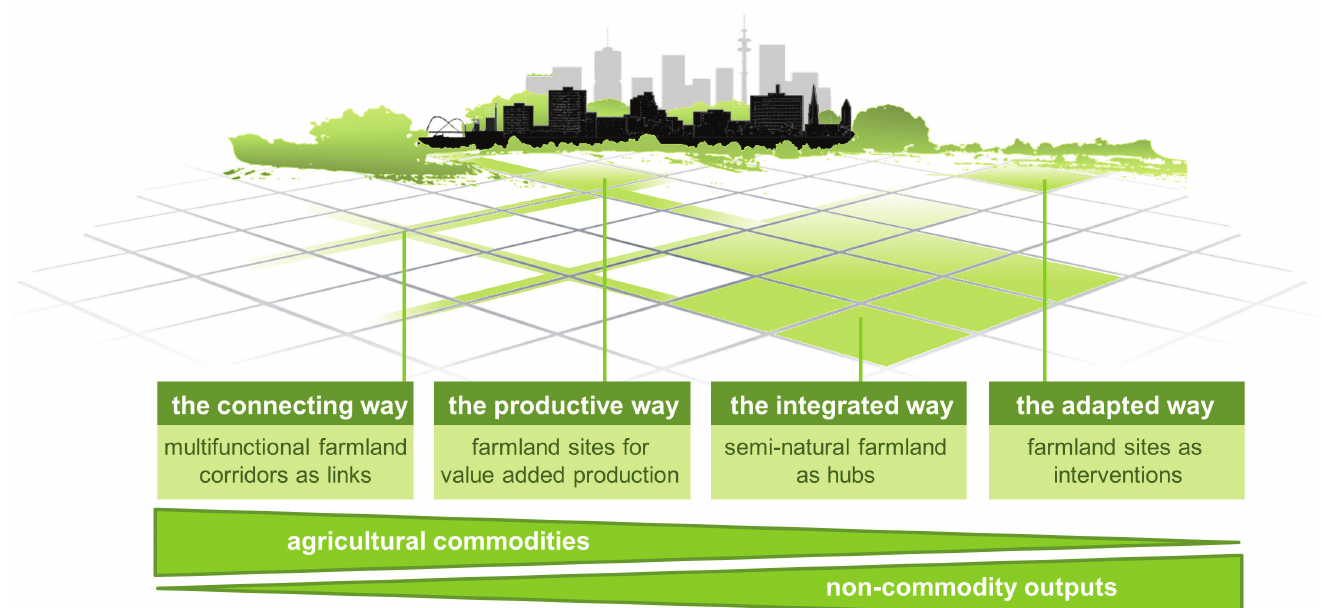
Figure 4. Schematic illustration of four ways linking farmland with the UGI concept and their relation to agricultural commodities and non-commodity outputs.